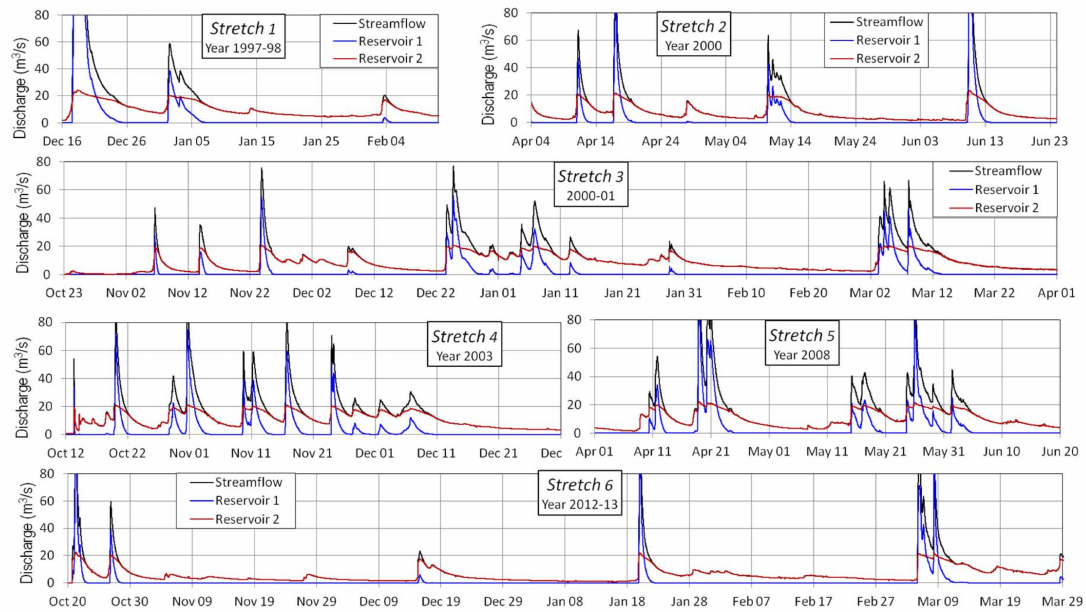
Figure 5. Calibration Flow separation for the six stretches selected of the time series with the 2R